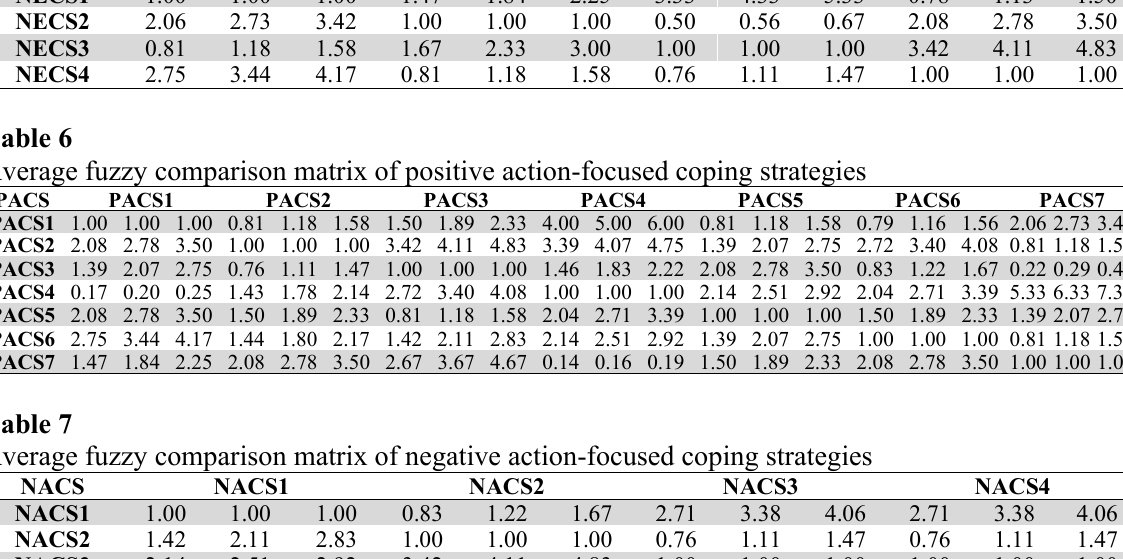
Average fuzzy comparison matrix of positive emotion-focused coping strategies PECS PECS1 PECS2 PECS3 PECS4 PECS5 PECS1 1.00 1.00 PECS3 PECS5 Average fuzzy comparison matrix of negative emotion-focused coping strategies NECS NECS1 NECS2 NECS3 NECS4 NECS1 1.00 1.00 1.00 NECS2 NECS3 0.81 1.18